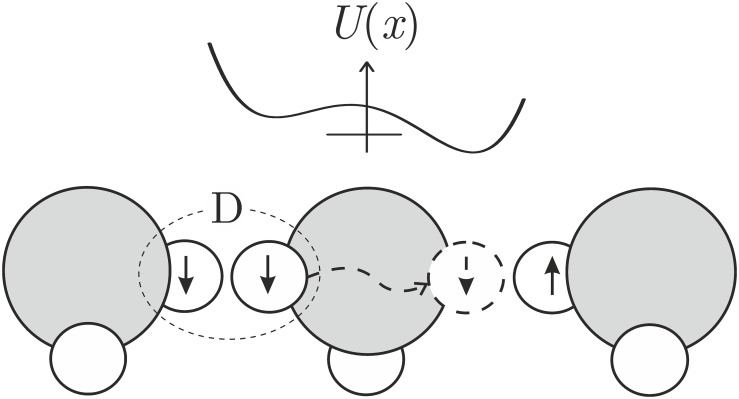
Motion of a D-defect due to the tunneling of a proton to the neighboring H-bond along the reaction coordinate x.White circles are protons, gray circles are oxygens. Shown are the exchange interaction potential U(x) of the tunneling proton and proton spin states.